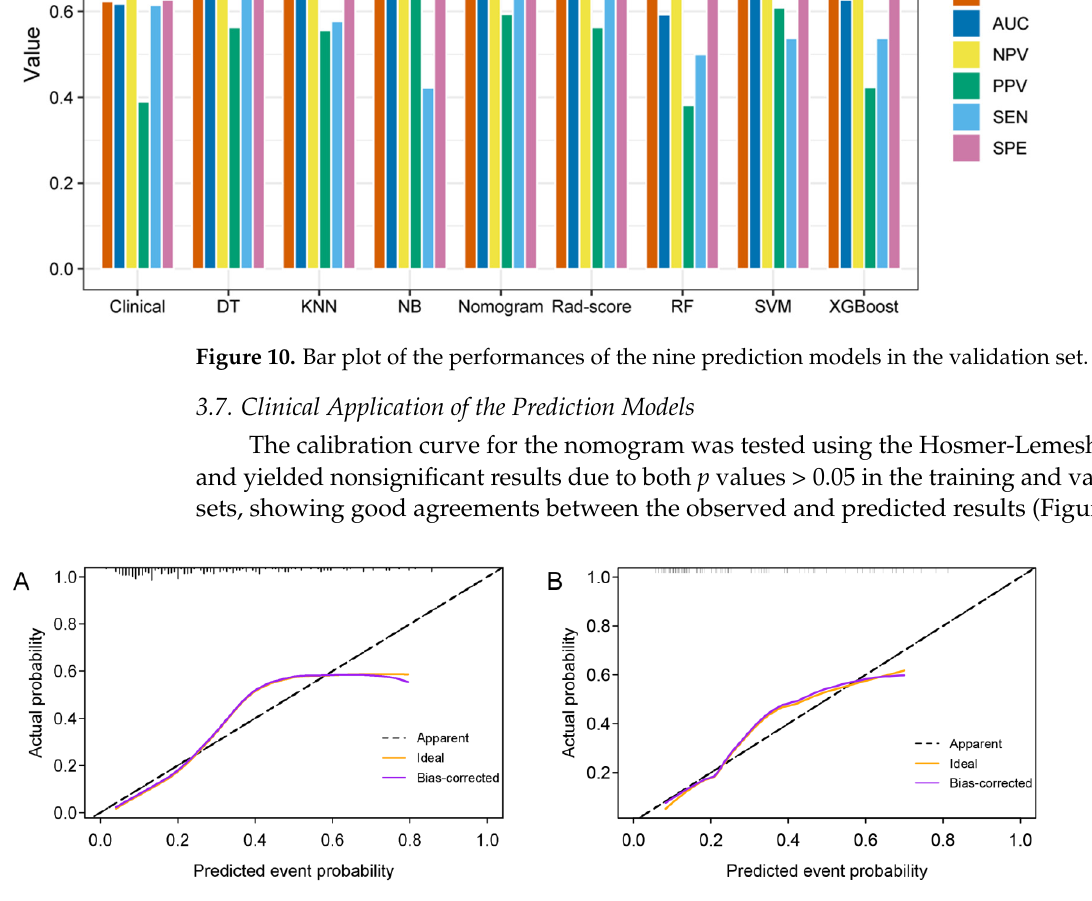
Figure 12. Decision curves of the models. If the risk threshold is less than 56.9%, the nomogram model will obtain more benefit than all treatment (assuming all breast cancer patients were HER2+) or no treatment (assuming all breast cancer patients were HER2 − ). 4. Discussion Mineable data can be extracted from digital medical images by radiomics and ana- lyzed to improve detection, diagnosis, staging, and prognosis prediction [20–22,24]. Ul- trasound radiomics might be helpful to answer questions like what the molecular subtype of BC is, and this might affect the treatment strategy in patients with BC. In our study, seven machine learning classifiers, such as KNN, LR, SVM, DT, NB, RF, and XGBoost, were established based on the Rad-score in the training set and tested in the time-independent validation set. Among them, the LR classifier with the AUC value of 0.786 performed the best, which might be that complex classifiers needed more training samples. Then the LR classifier was selected as the Rad-score model. The results indicated that the ultrasound-related Rad-score could predict the HER2+ status of patients with breast carcinoma. In addition, by establishing a nomogram model combining the Rad- score with clinical risk factors, we found that the nomogram model had significantly im- proved predictive performance compared with the model only involving clinical risk fac- tors (AUC, 0.788 vs. 0.618, in the validation set) and slightly improved the ability com-